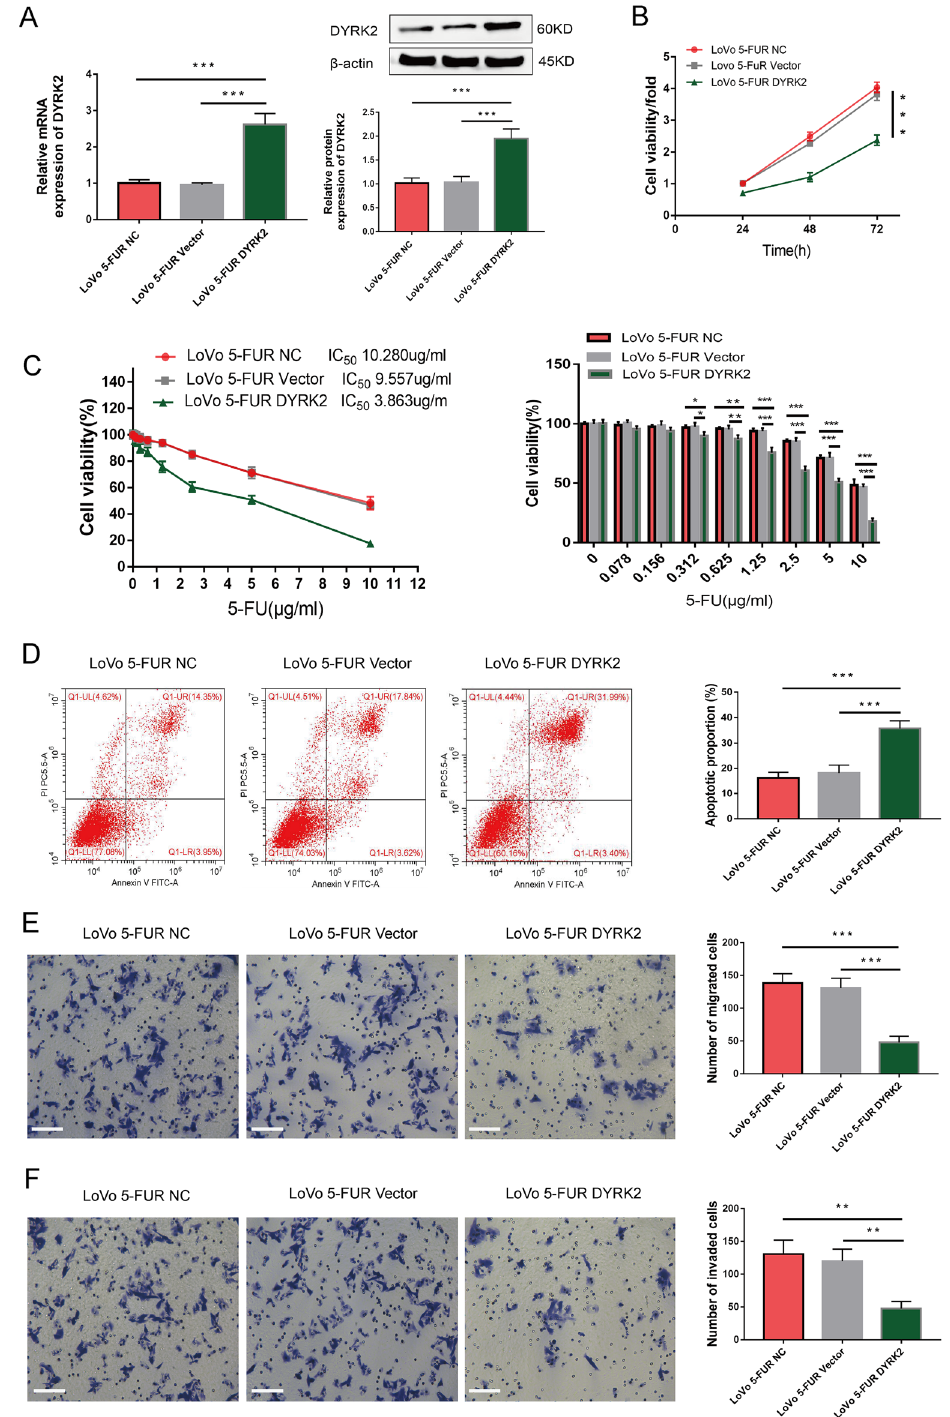
Figure 4. DYRK2 overexpression enhances 5-FUR LoVo cell chemosensitivity and apoptotic death while inhibiting migratory, proliferative, and invasive activity. ( A ) DYRK2 expression in the indicated cells was assessed via qPCR and Western blotting. ( B , C ) A CCK-8 assay was used to assess cell viability and chemosensitivity. ( D ) Apoptosis was detected via flow cytometry. Migration ( E ) and invasion assays ( F ) were used to detect the malignant properties of the indicated cells. Scale bar: 50 μm (× 200). Data are means ± SD (n = 3). * P < 0.05, ** P < 0.01, *** P <